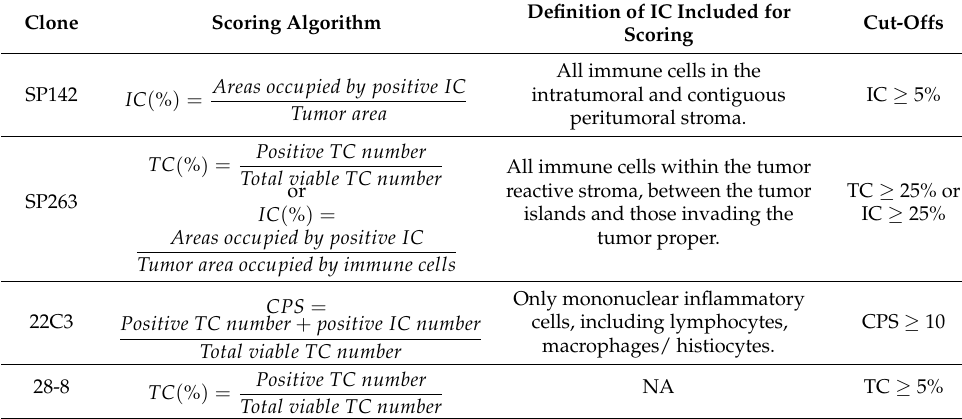
Definition of IC Included for Scoring